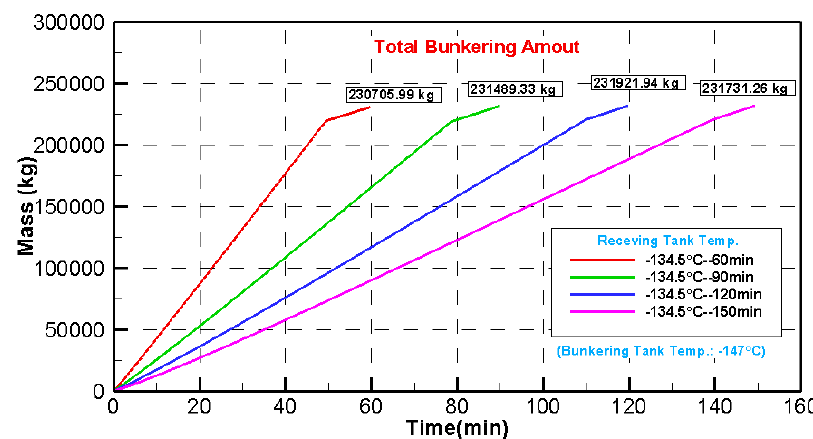
Figure 10. Total bunkering amounts with respect to different bunkering times and pump stops . Table 5. Quantity of state respect to different bunkering time limits (Finish Bunkering). Bunkering Time Limit (min.)